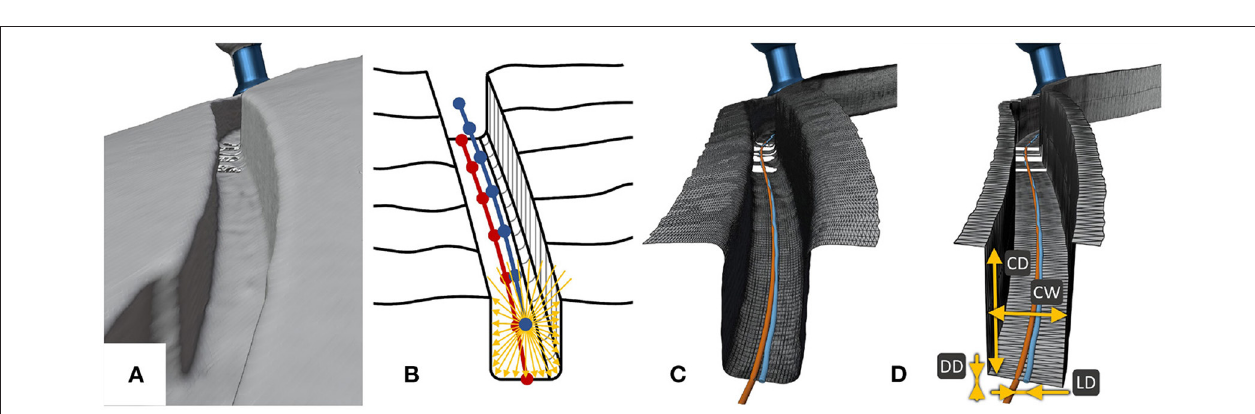
FIGURE 5 | The process for the analysis of the milled channels. (A) The reconstructed surface of the resulting electrode channel from the micro-CT. (B) This reconstructed surface was sampled radially to the approximate channel center line, resulting in (C) a resampled surface containing only the channel, which was then classified into top left, top right, left wall, right wall and bottom. (D) The measurements through these classifications were displayed as a simplified version of the channel, where CD stands for channel depth, CW for channel width, DD for depth displacement, and LD for lateral